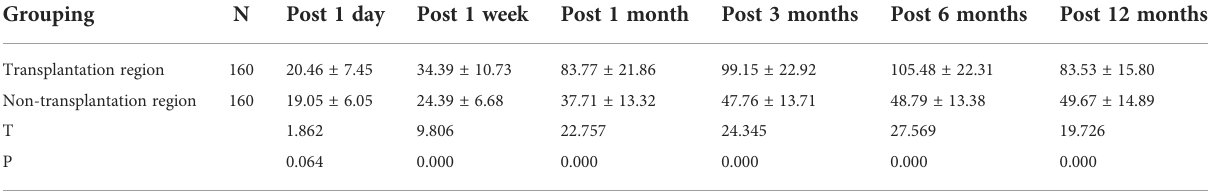
TABLE 5 Comparison between cubital fossa vein PTH in transplantation region and non-transplantation region in the experimental group (pg/mL, X±S). Grouping N